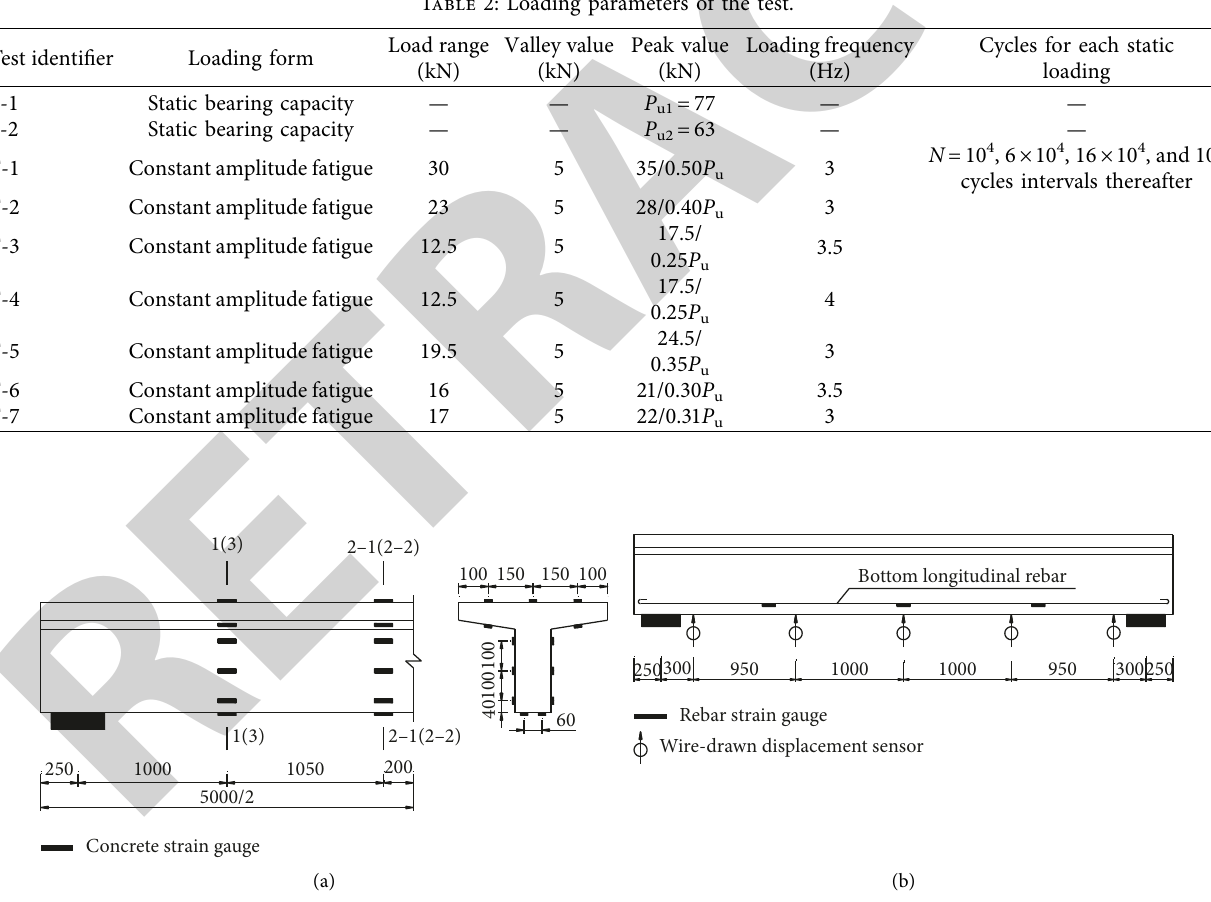
Figure 3: Arrangements of strain gauges and deflection for the test girders (unit: mm). (a) Concrete strain gauge arrangements. (b) Rebar strain gauge and displacement measurement